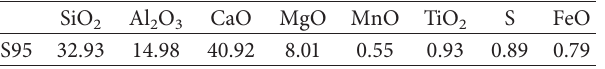
Table 1: Chemical components of blast furnace slag (%).